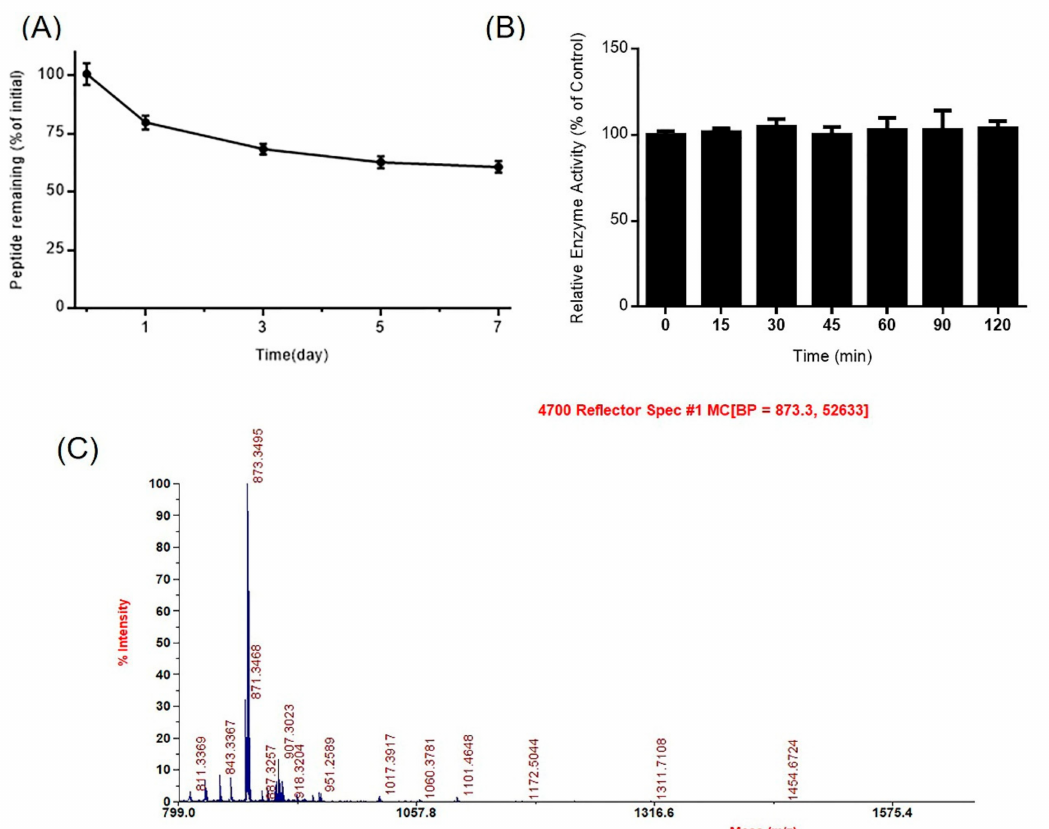
Figure 3. Stability of DhHP-6 in plasma. ( A ) The remaining DhHP-6 of the degradation products collected at scheduled time was analyzed by HPLC after DhHP-6 was incubated in plasma at 37 ◦ C. ( B ) The degradation products were determined by HPLC-MS. ( C ) The relative enzyme activity of the degradation products was analyzed by the H 2 O 2 –Vitamin C double-substrate method. All results presented are means ± SD from three independent experiments.